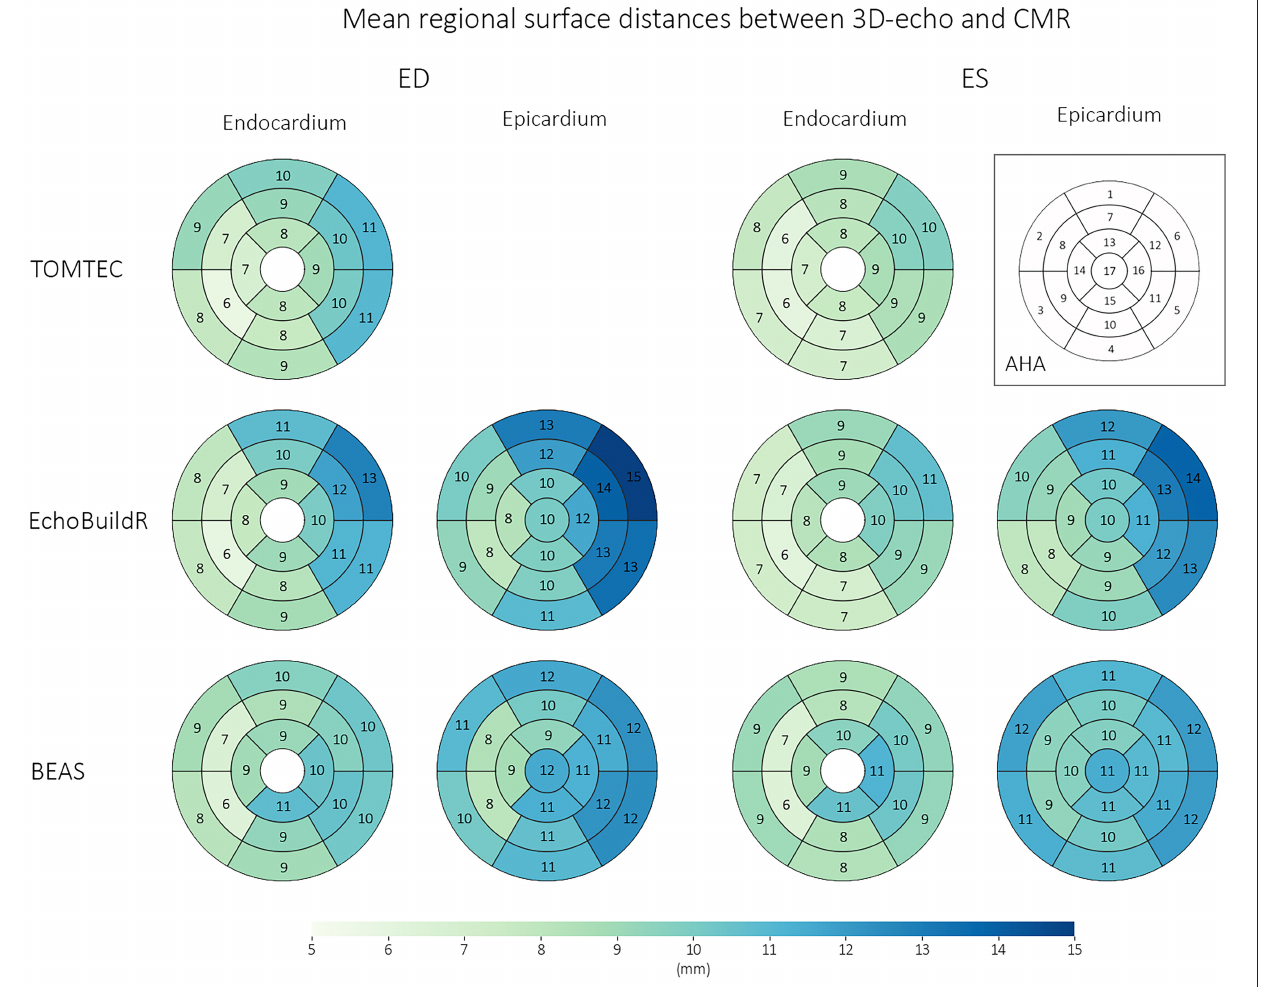
FIGURE 4 | Regional surface distances (for the endocardium and epicardium) between corresponding 3D-echo and CMR models across n = 70 subjects, at ED and ES. Numbers represent mean surface distances in mm.